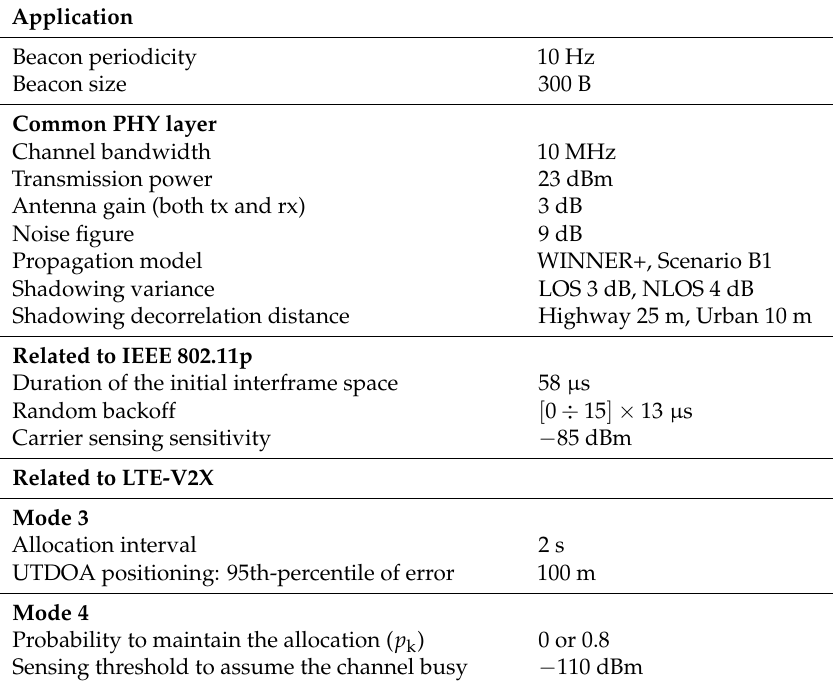
Table 5. Main simulation parameters and